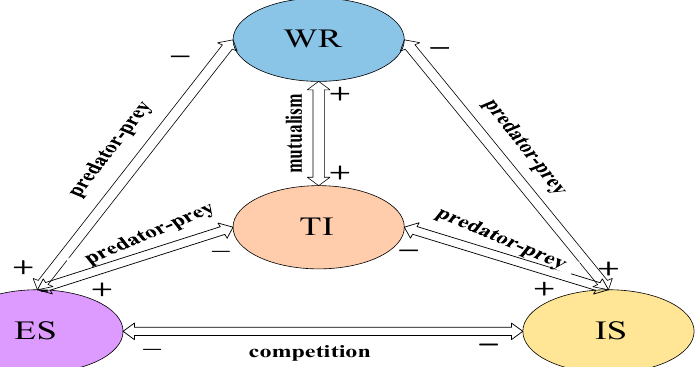
Figure 5. The relationship between Water Resources System-Economy System-Industrial System- Technology Innovation System in Tianjin. (3) Hebei area By combining the above formulas to calculate the 12 indicators of the four systems in Hebei, Equation (34), Figure 6 are obtained.